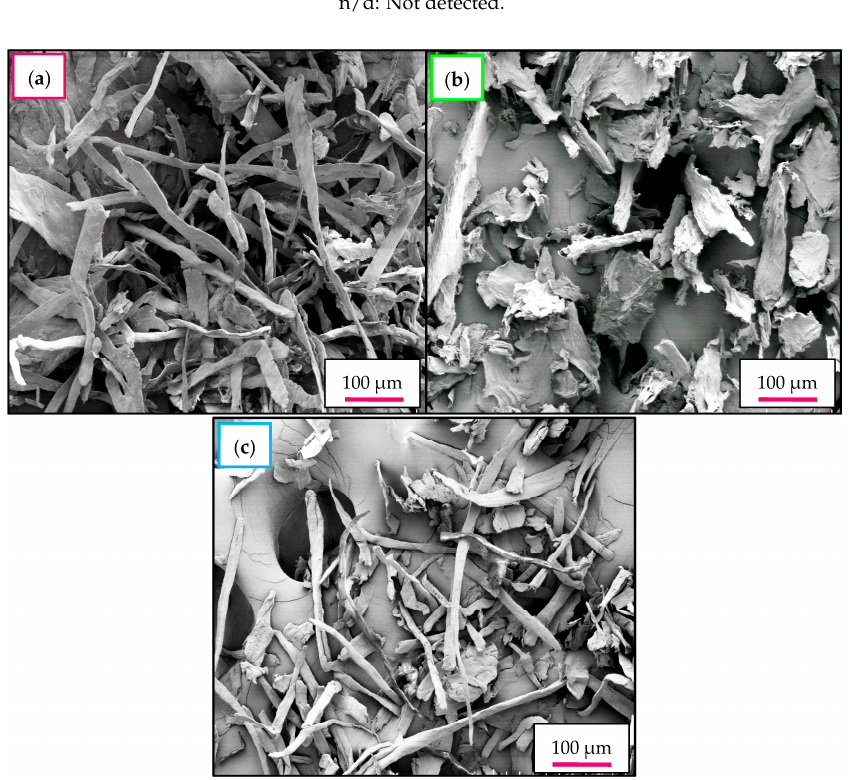
Figure 4. FESEM images of: ( a ) Native cellulose; ( b ) CNC H2SO4 ; and ( c ) CNC Cr(NO3)3 . It is worth